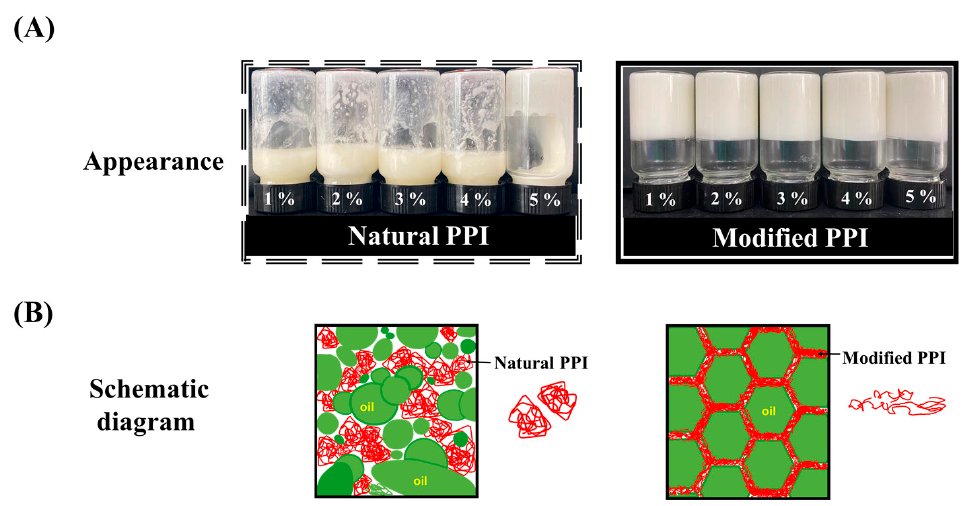
Figure 1. ( A ) Appearance of HIPEs stabilized by natural PPI and modi fi ed PPI at di ff erent concen- trations (1–5 wt%). ( B ) Mechanism schematic diagram of HIPEs stabilized by natural PPI and mod- i fi ed PPI.